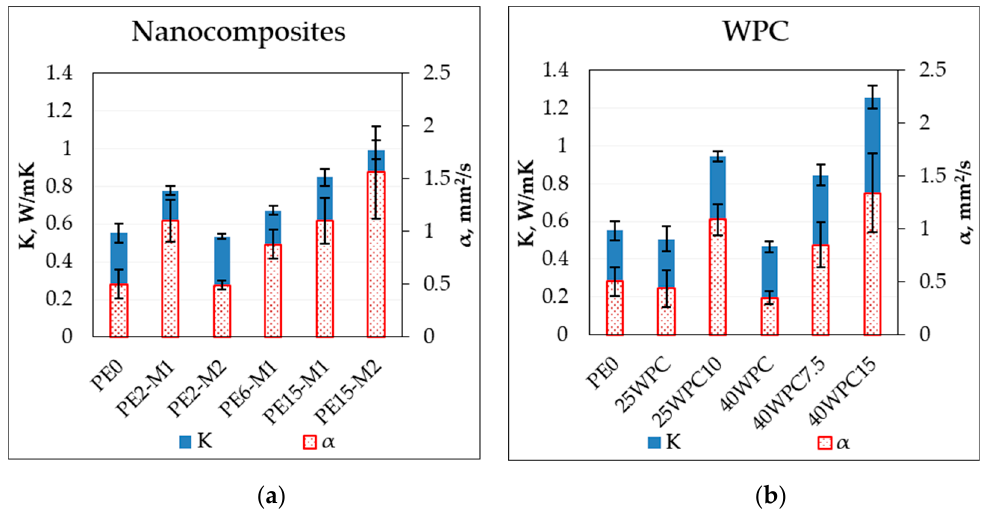
Figure 9. Thermal conductivity and diffusivity of ( a ) the nanocomposites; and ( b ) the wood polymer composite.